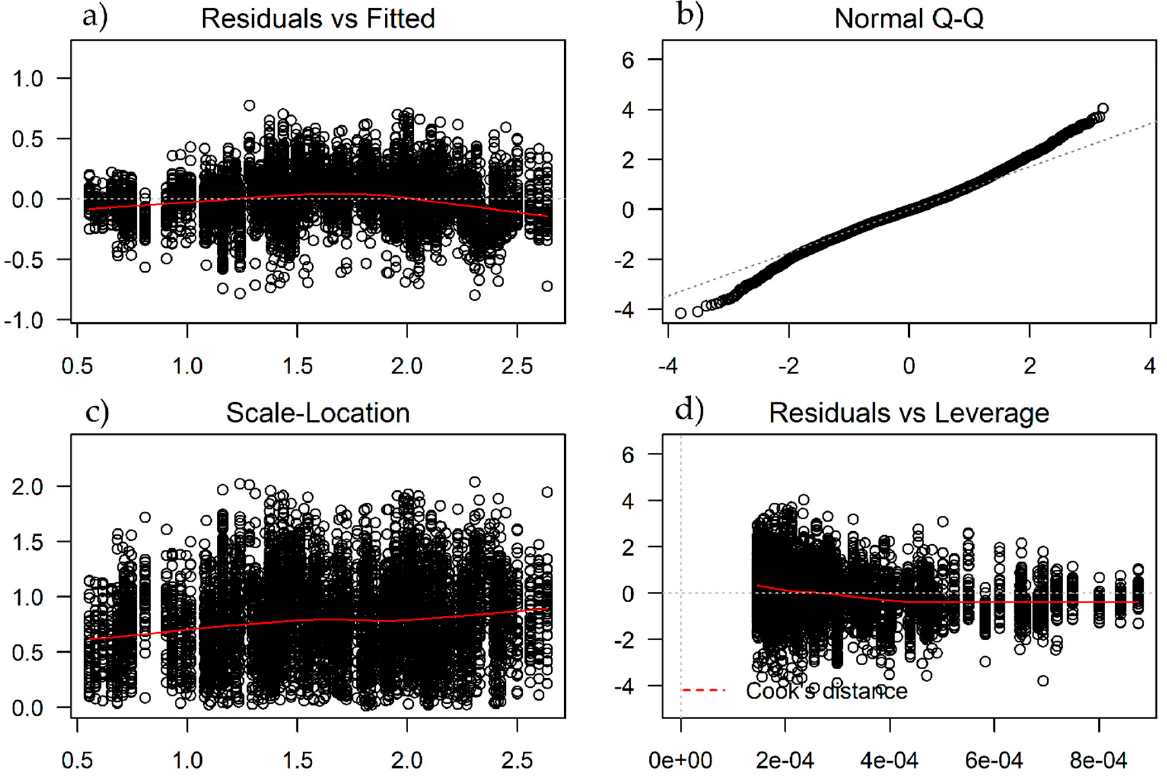
Figure 8. Graphs about residuals analysis: ( a ) residuals versus fitted values, ( b ) QQ-plot, ( c ) standardised residuals versus fitted values, and ( d ) residuals versus average.